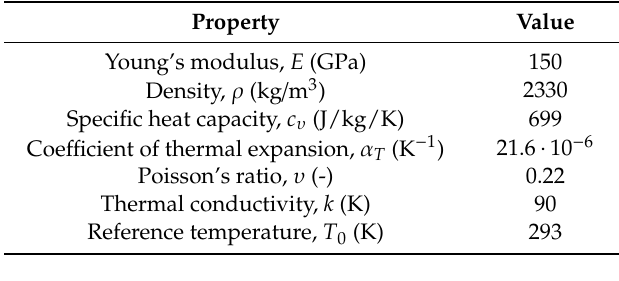
Table 1. Polysilicon micro-bridge physical properties.